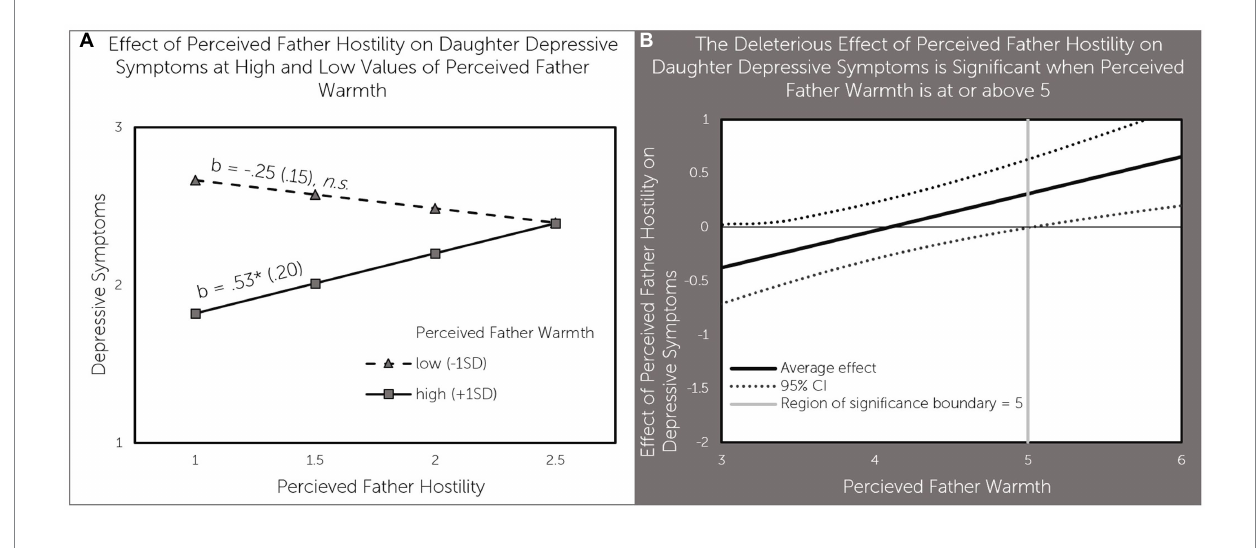
FIGURE 2 Perceived father warmth moderates the effect of perceived father hostility on daughter depressive sympotoms (A) effect of perceived father hostility on daughter depressive symptoms at high and low values of perceived father warmth; (B) the deleterious effect of perceived father hostility on daughter depressive symptoms is significant when perceived father warmth is at or above 5.